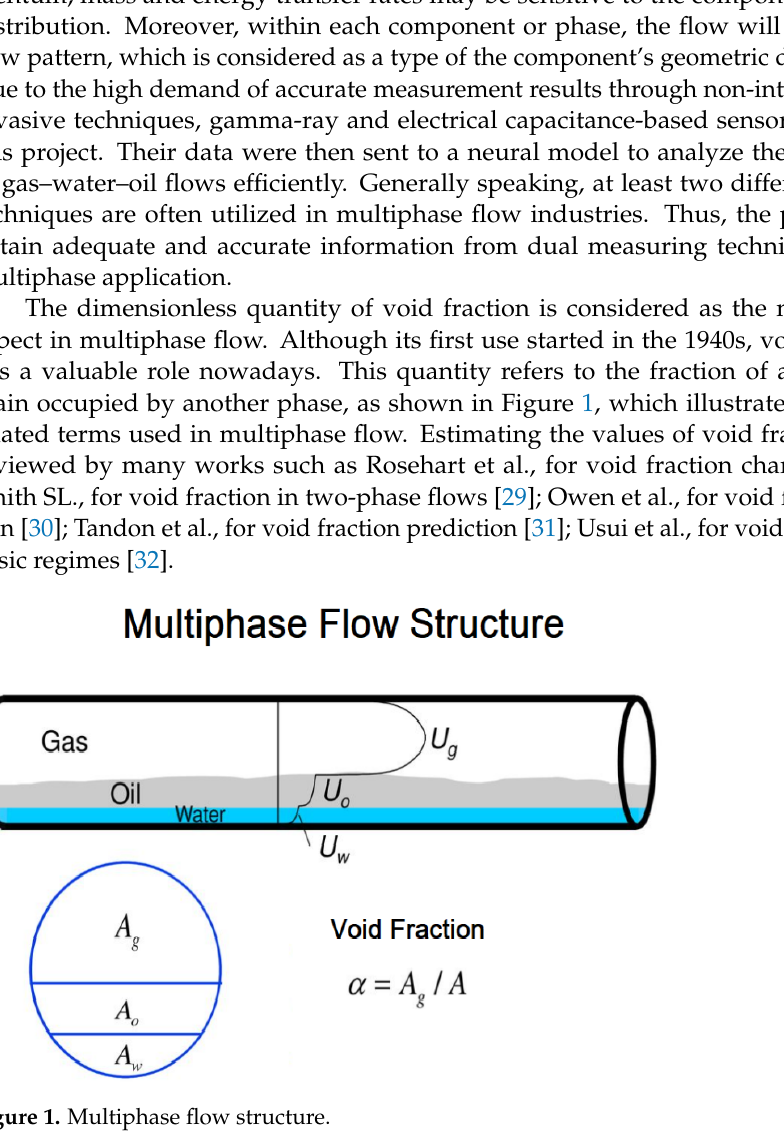
Figure 1 . Multiphase flow structure . Figure 1. Multiphase flow